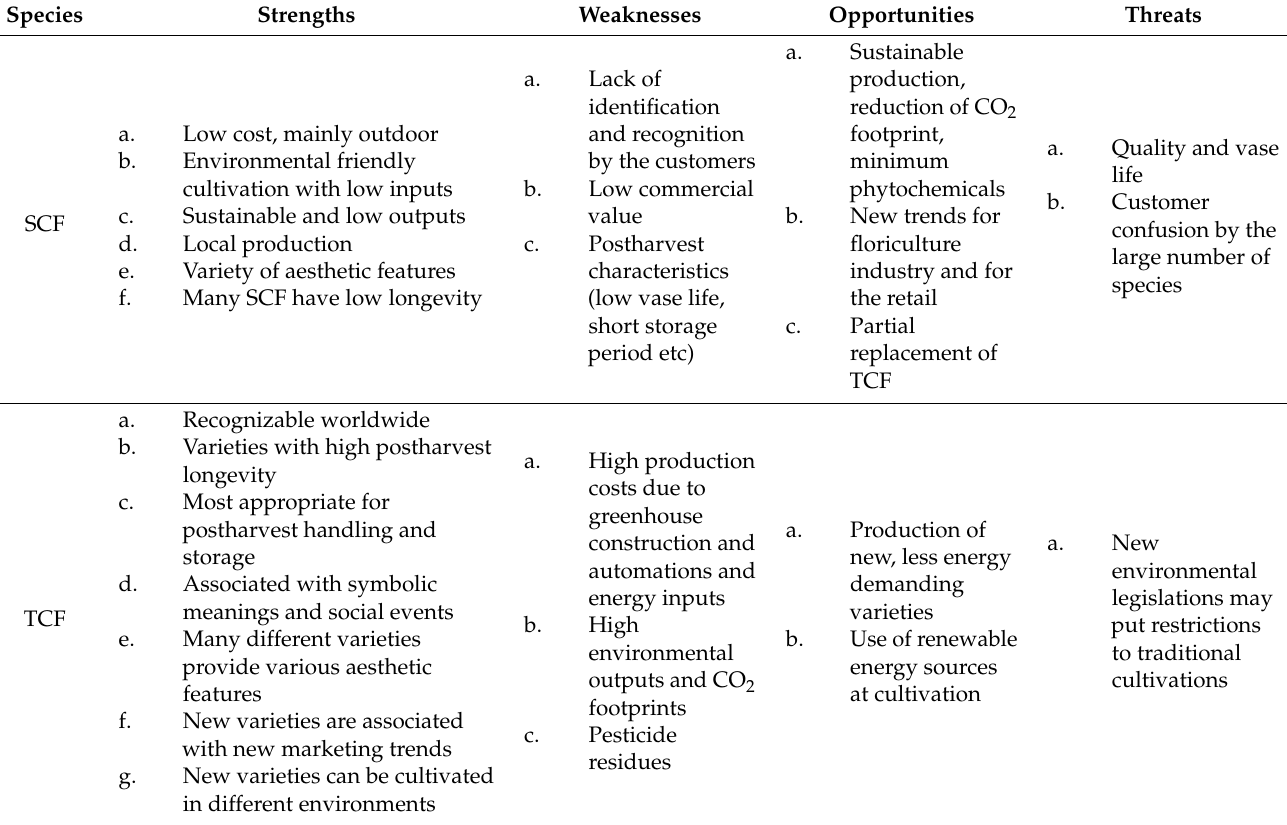
Table 2. Strengths, weaknesses, opportunities, and threats (SWOT) of SCF and TCF cultivated worldwide. Species